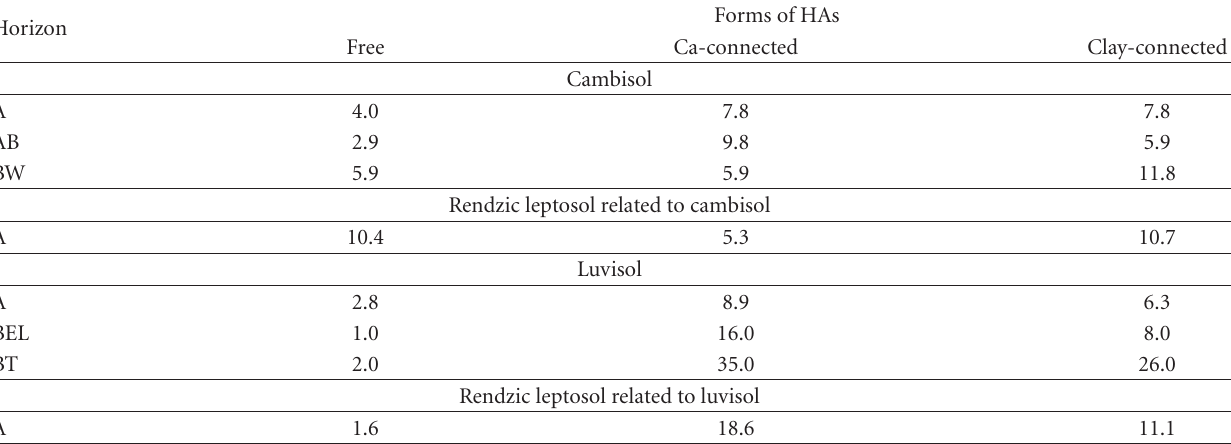
Table 2: The groups of HAs in soils: Percentage of humic acid carbon to total C content.